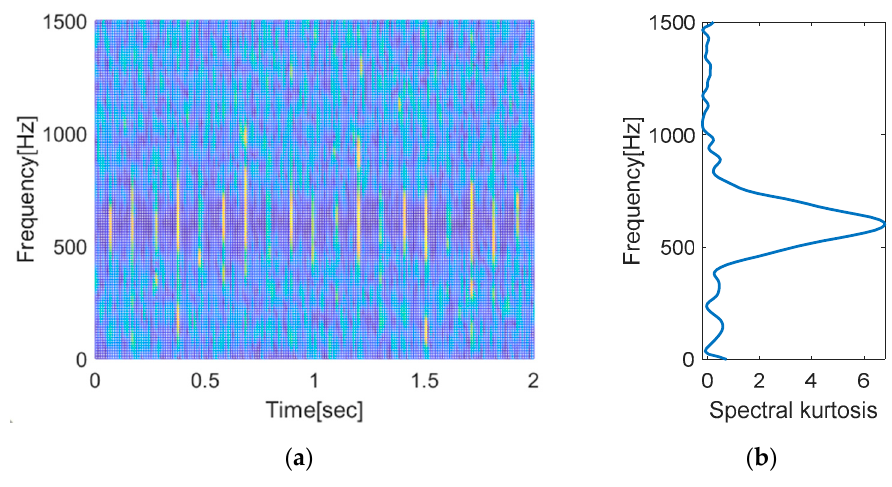
Figure 9. Results of STFT and SK: ( a ) STFT S ( t, f ) and ( b ) SK K ( f ).